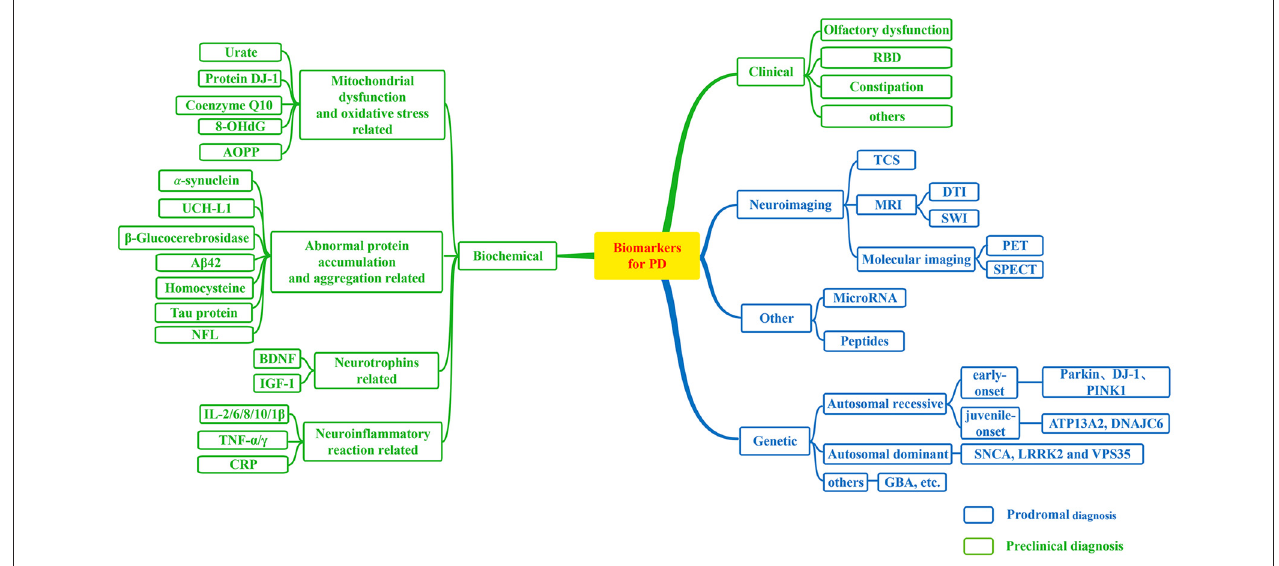
FIGURE 1 | Biomarkers for Parkinson’s disease (PD). A flow figure illustrates various major biomarkers in PD. Biomarkers can be divided into following broad categories; and biomarkers in blue grids can be used to prodromal diagnosis for PD, while biomarkers in green grids may be helpful in the detection of preclinical PD as illustrated in this